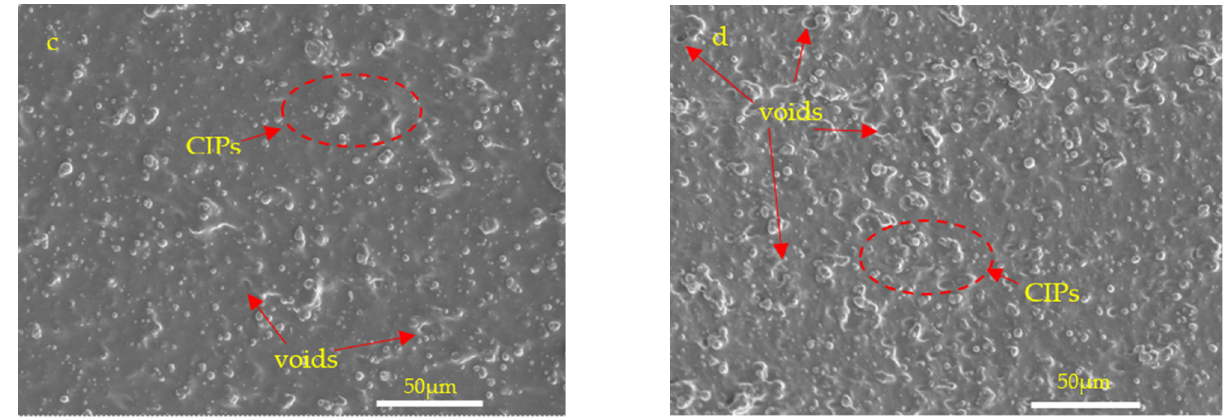
Figure 1. Morphological analysis of the SR-MREs cross-section with 30 wt% CIPs ( a ) before and ( b ) after thermal aging, and SR-MREs with 60 wt% ( c ) before and ( d ) after thermal aging.